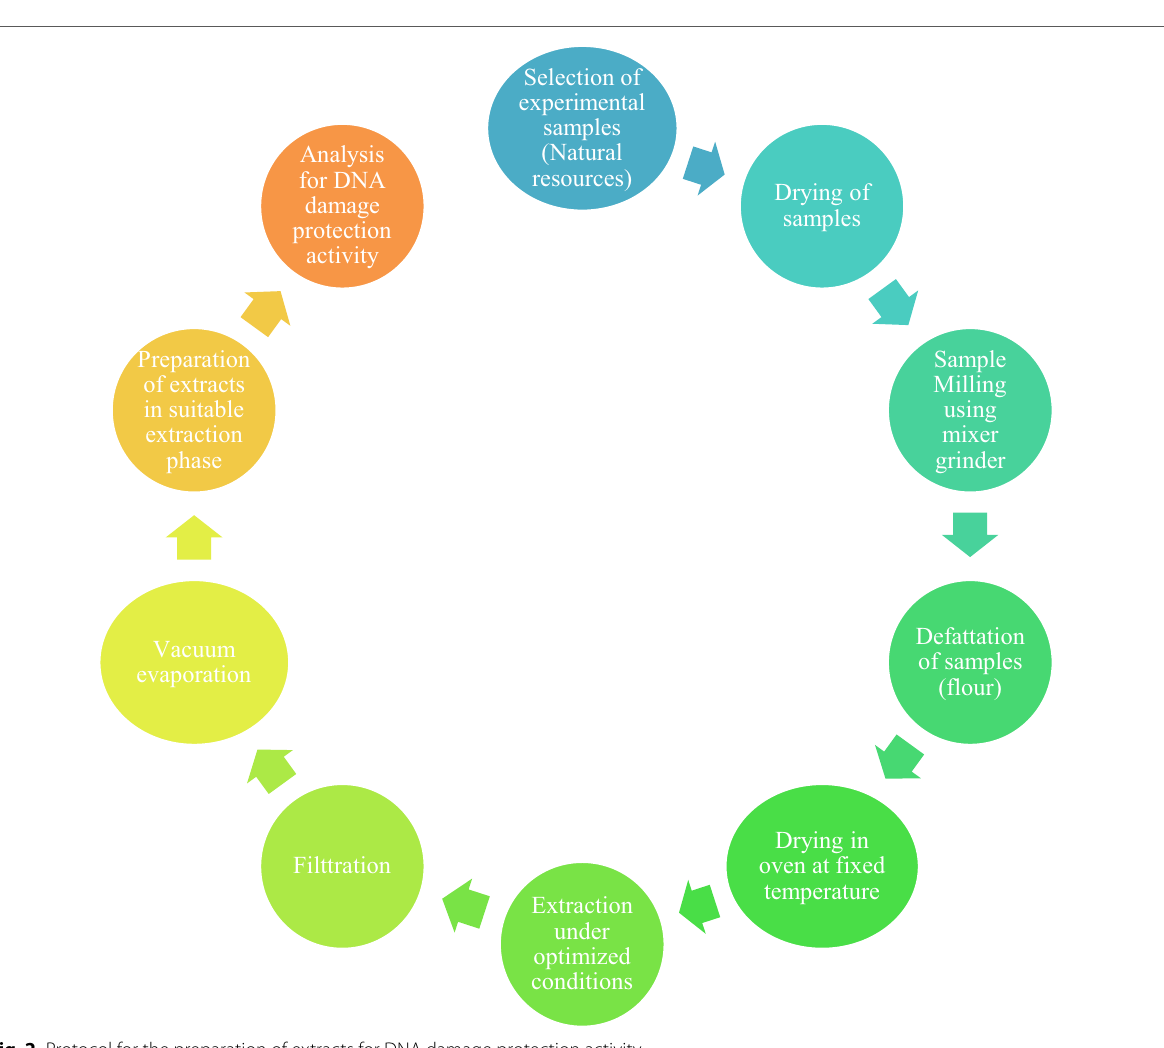
Fig. 2 Protocol for the preparation of extracts for DNA damage protection